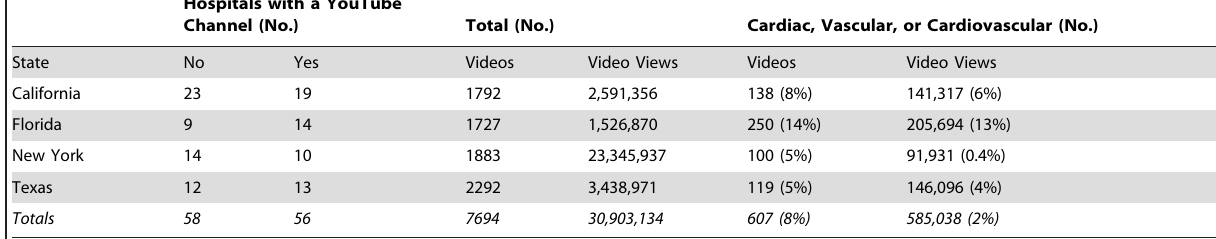
Hospitals with a YouTube Channel (No.)